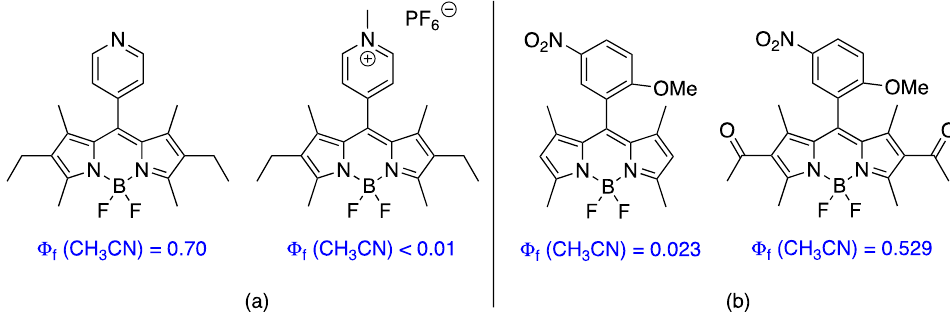
Figure 2. Previous work on modulating the fluorescent properties of BODIPY dyes: ( a ) effect of N -methylation of a meso -(4-pyridyl)-BODIPY [32], and ( b ) effect of introduction of acetyl groups at the 2,6-positions of a meso -aryl-BODIPY [34].